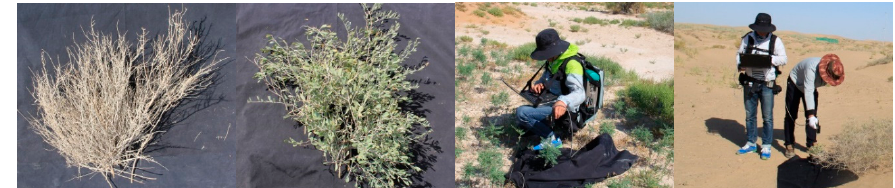
Figure 3. Photosynthetic and non-photosynthetic vegetation (PV, NPV) endmember-spectrum collection in Minqin, China. Di ff erent protocols tested for endmember-spectrum acquisition. Process of excising PV or NPV canopy either placed on black background or directly placing black cloth under their canopy, then completely covering soil ground to ensure endmember-spectrum purity.